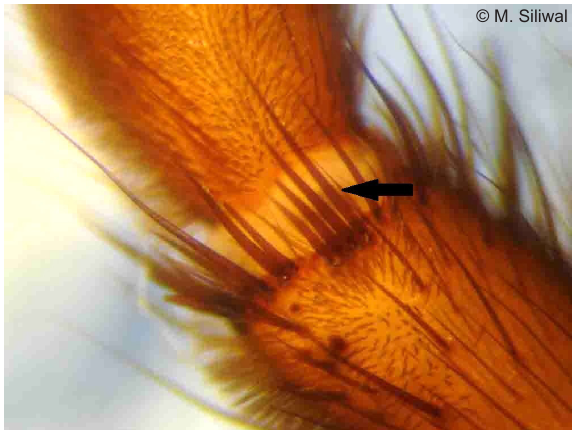
Image 1. Preening comb on metatarsi, a distinguishing character of the genus Tigidia